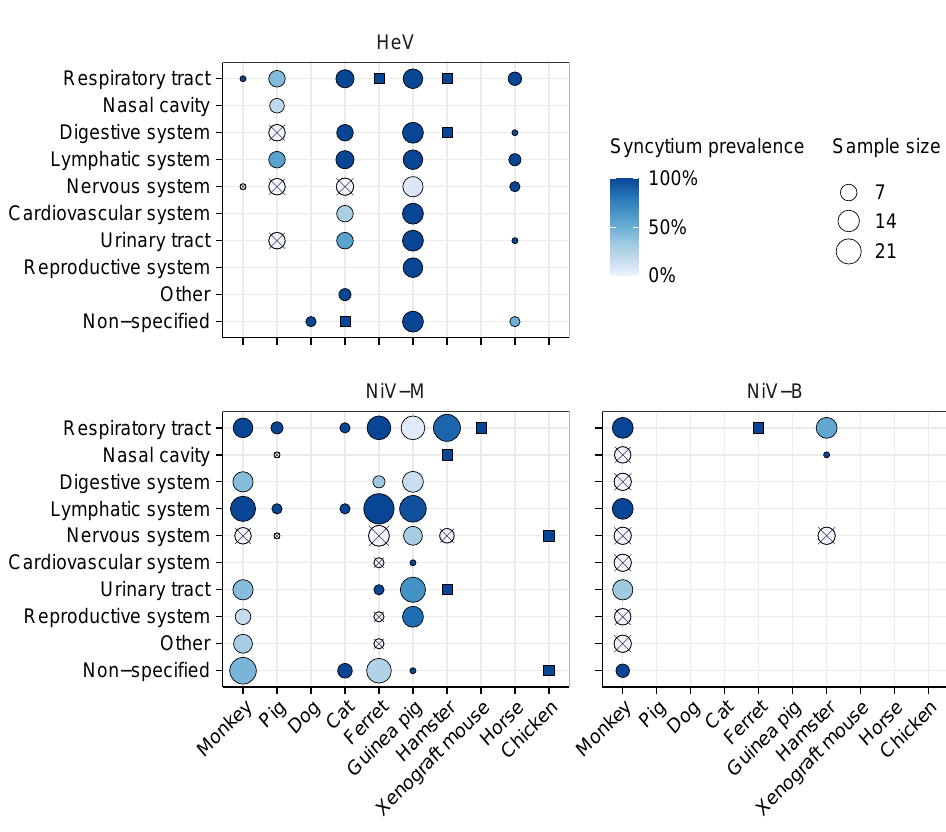
Figure 4. Proportion of individuals presenting syncytia in different tissues following experimental henipavirus infection in vivo. Crossed circles indicate that no syncytia were observed; dark blue squares indicate that syncytia were observed but the exact proportion of individuals is unknown; blank spaces indicate that no data are available. Data obtained using different inoculation routes or doses and collected at different times post-infection were merged together. Available immunohis- tochemistry (IHC) data and the proportion of individuals presenting viral antigens are plotted in Figure S3 for comparison. Data were extracted from the studies listed in Table